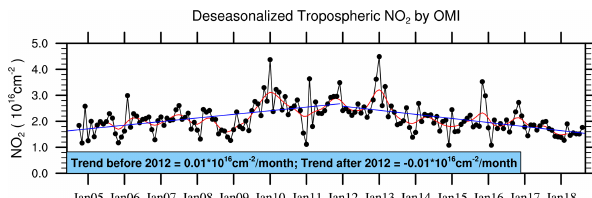
Figure 5. Deseasonalized monthly mean columns of tropospheric NO 2 (solid black lines and dots) and the corresponding Gaussian- weighted means using a half width of 12 months (red curves). The blue lines estimate the linear trend before and after the sudden de- crease of ozone during late 2011 and early